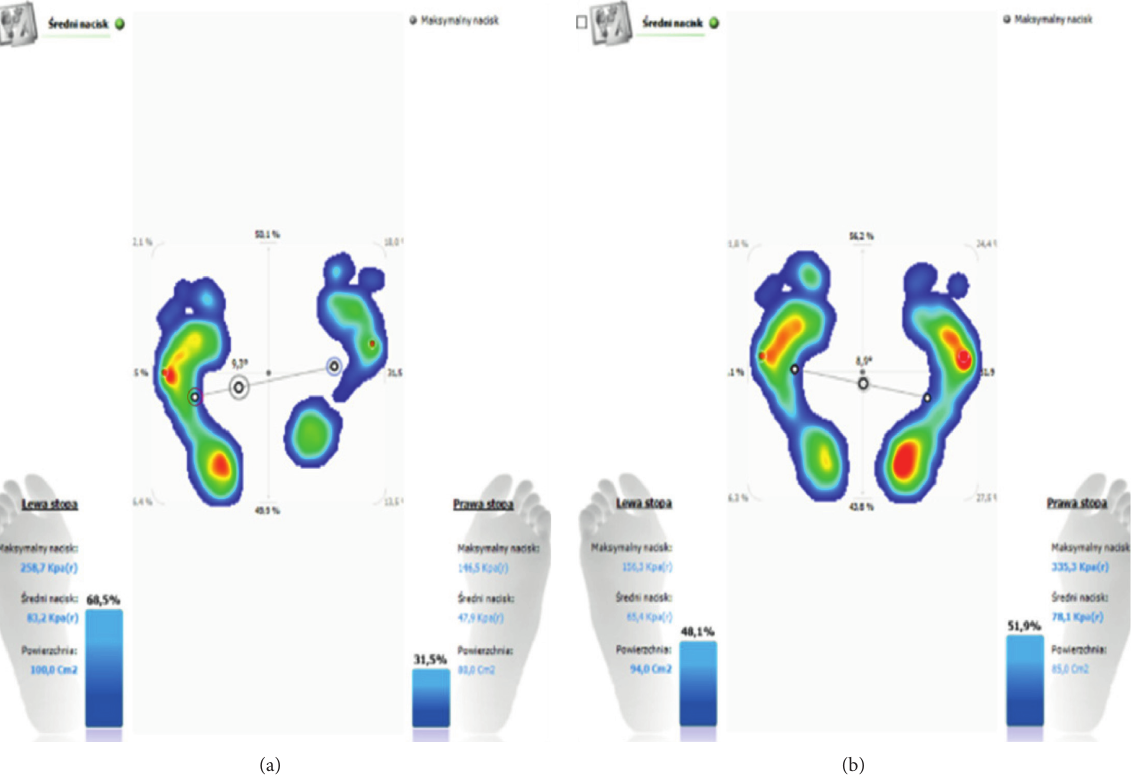
Figure 4: (a) Distribution of pressure in the anterior/posterior and lateral view and the angle of the relation of the feet before repositioning the mandibular head in the articular fossa and stabilizing the position of the condylar process with a temporary silicone occlusive splint. (b) Distribution of pressure in the anterior/posterior and lateral view and the angle of the relation of the feet after repositioning the mandibular head in the articular fossa and stabilizing the position of the condylar process with a temporary silicone occlusive